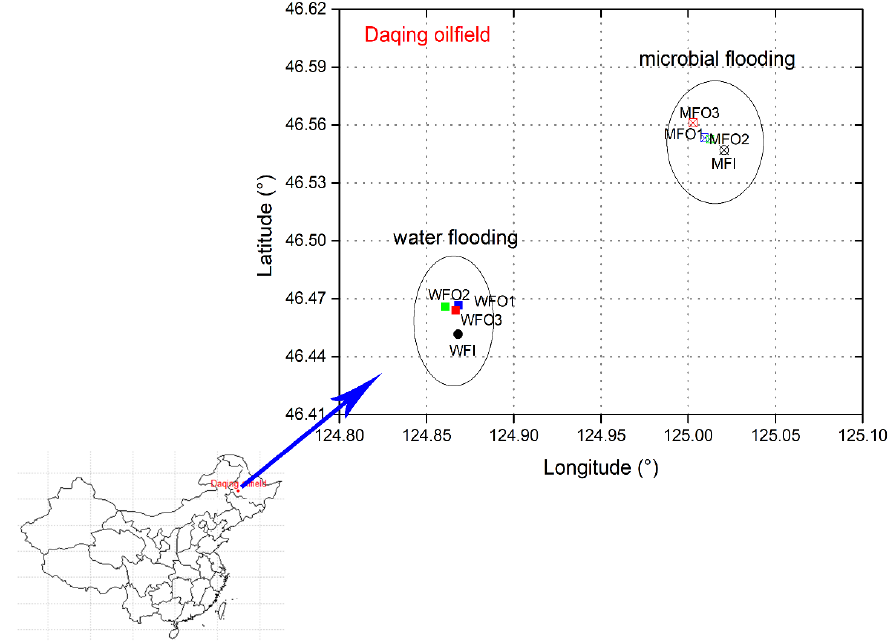
Figure 1. Sampling location for this study in the Daqing oilfield, China.